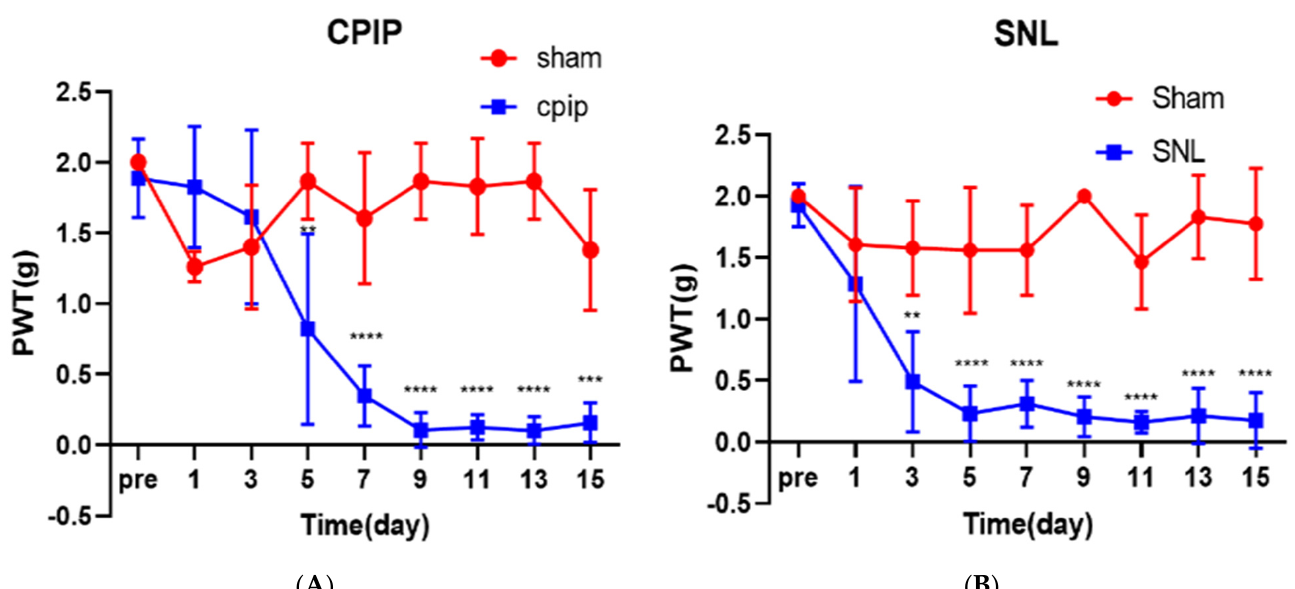
Figure 1. The Von Frey test showed the time course of allodynia in the left hind paw of CPIP ( n = 6) mice and Sham ( n = 4) group, SNL ( n = 6) mice and Sham ( n = 4) group mice. ( A ) During the entire 15-day test, the withdrawal threshold of the mice in the Sham group did not change significantly. The paw withdrawal threshold of the CPIP mouse was significantly decreased on the 4th day after reperfusion and continued to the 15th day. ( B ) During the 15-day test, the withdrawal threshold of the mice in the Sham group did not change significantly. The withdrawal threshold of SNL mice was significantly reduced and lasted for 15 days after reperfusion. CPIP, chronic post-ischemic pain; SNL, spinal nerve ligation. ** p < 0.005, *** p < 0.001, **** p < 0.0001 at each time point compared to that in the normal